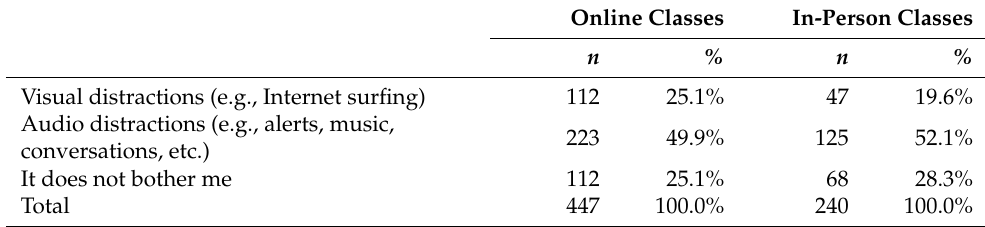
Online Classes In-Person Classes